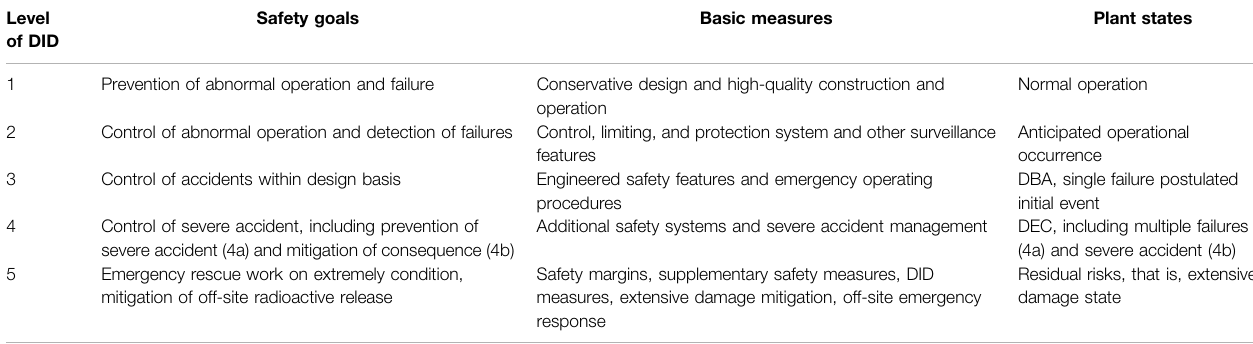
TABLE 3 | Enhanced defense in depth level